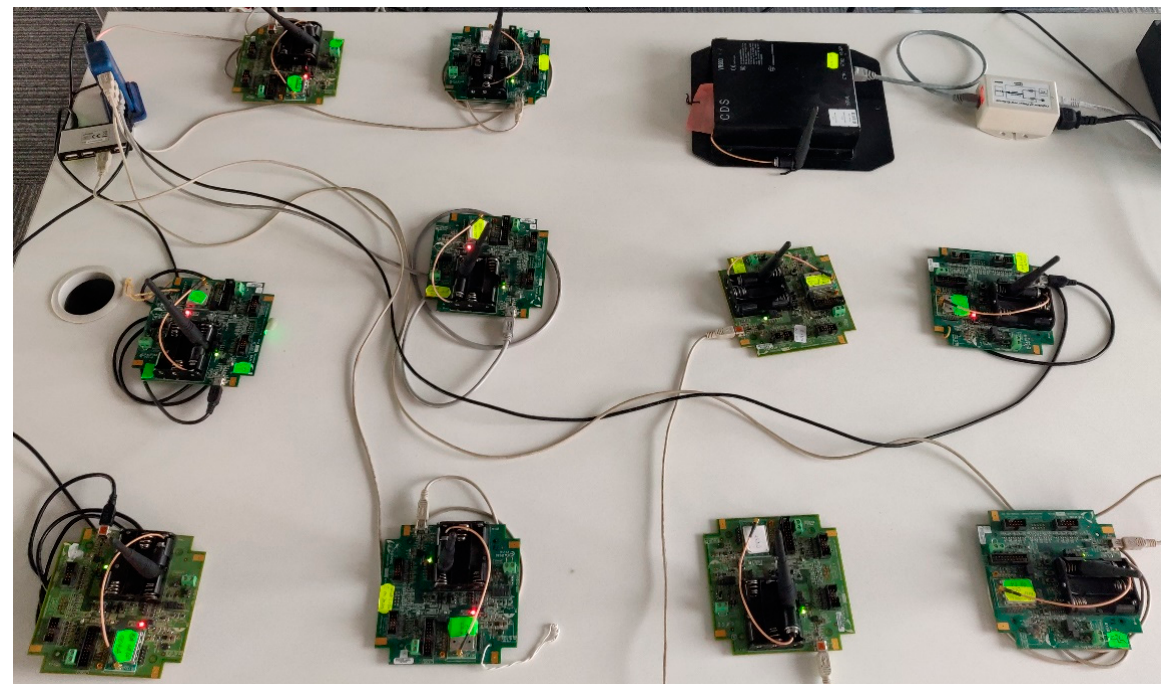
Figure 8. Extended real scenario implementation.